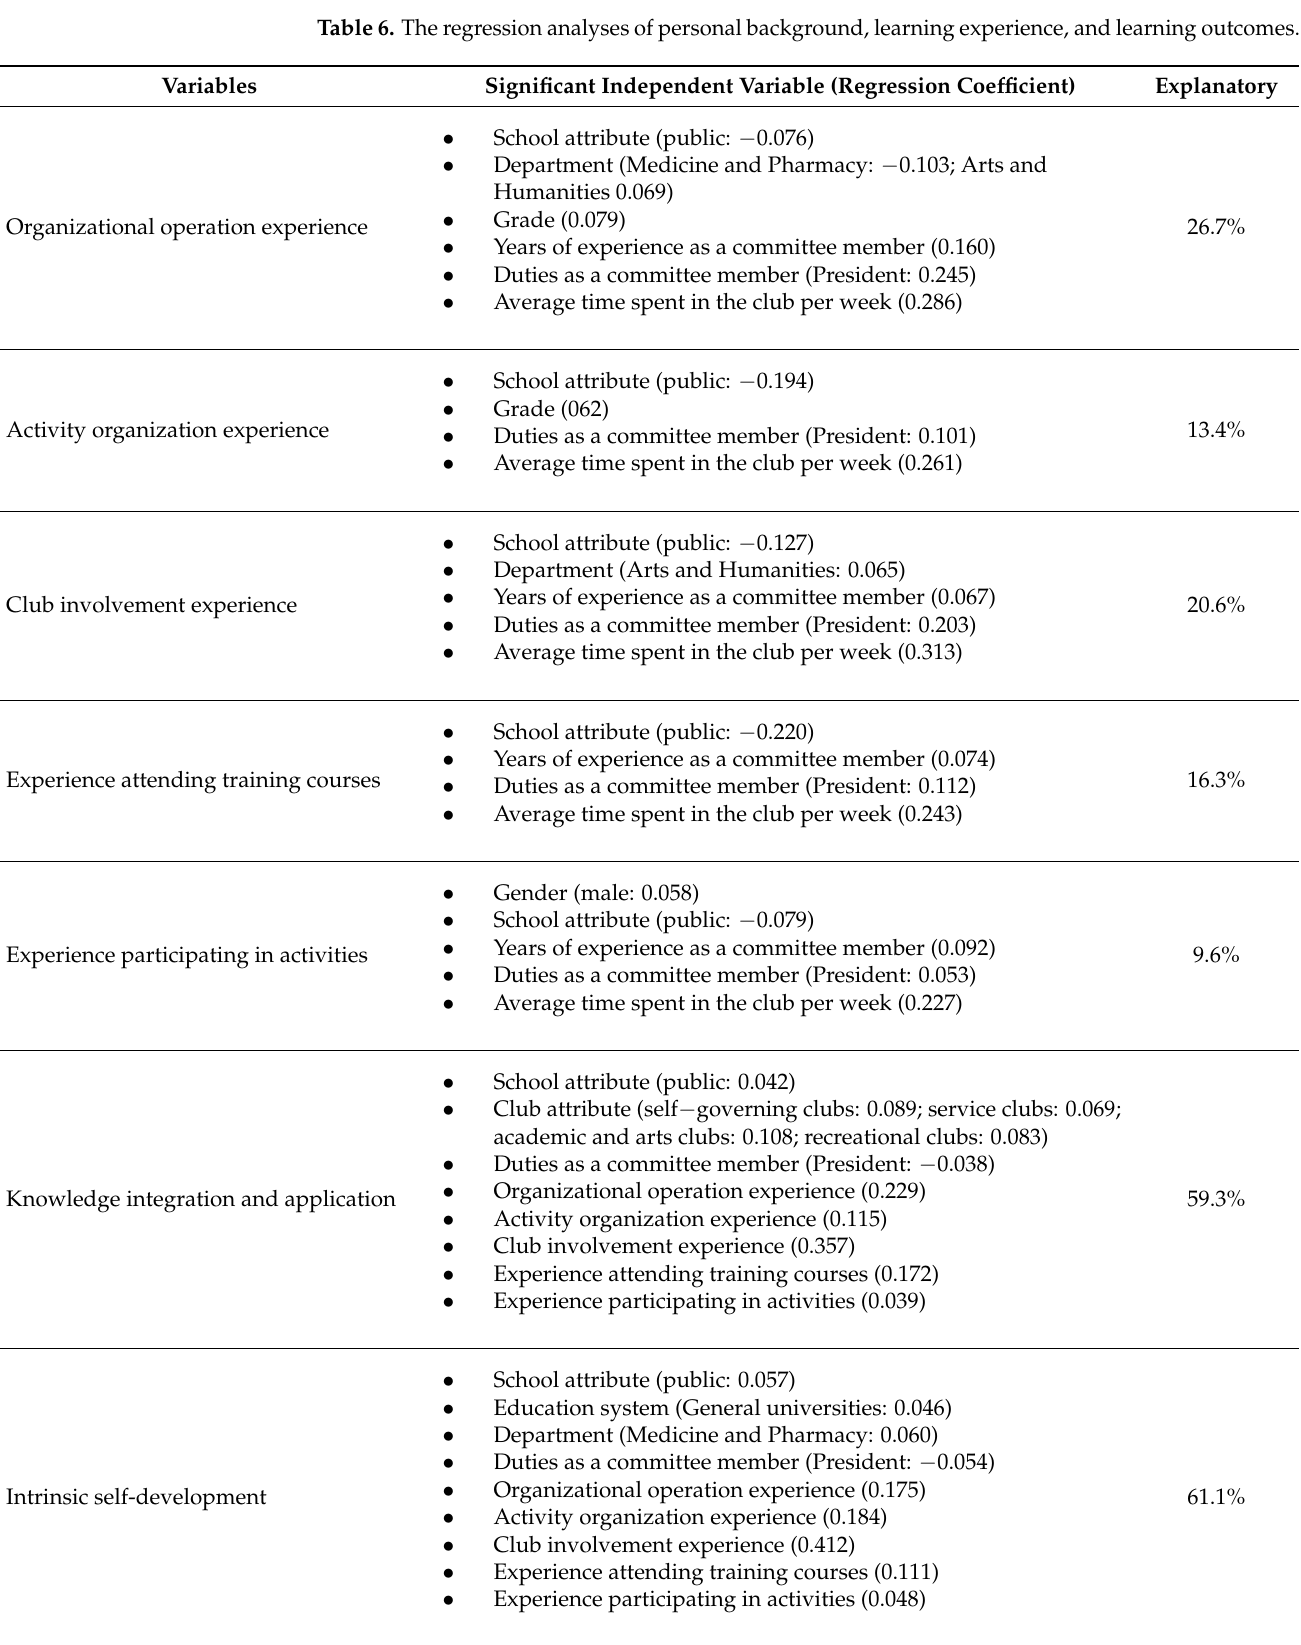
Table 6. The regression analyses of personal background, learning experience, and learning outcomes.